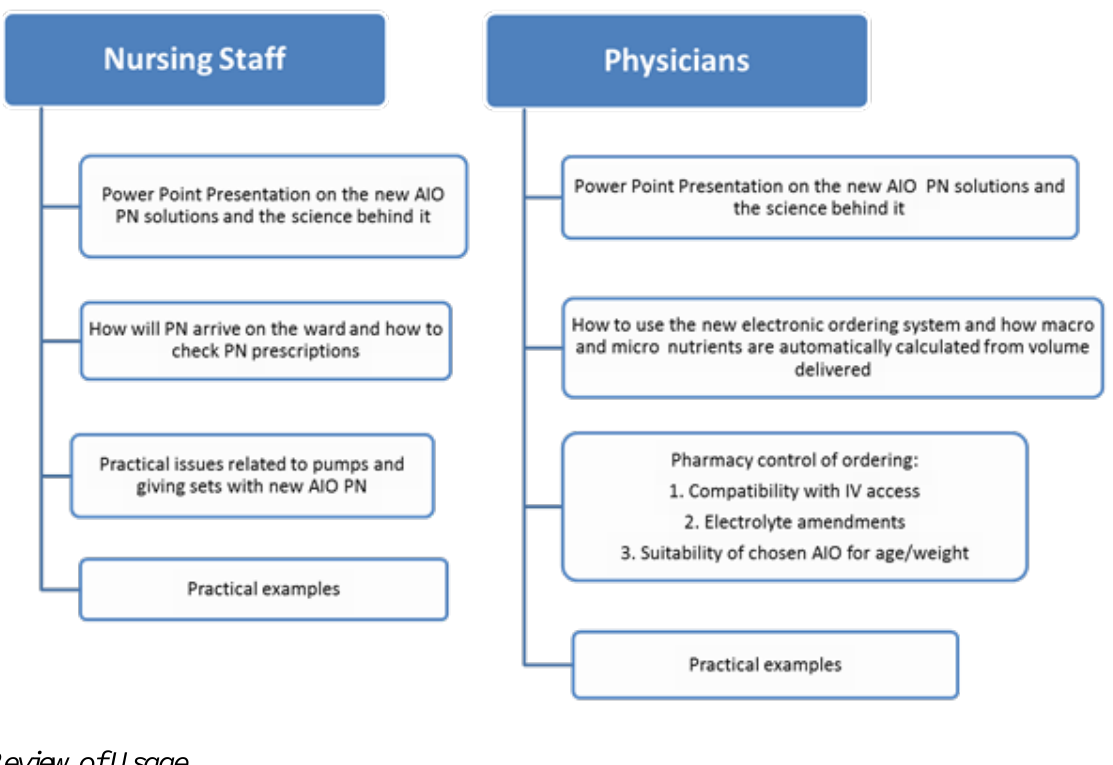
Figure 2. Information provided during teaching for physicians and nursing